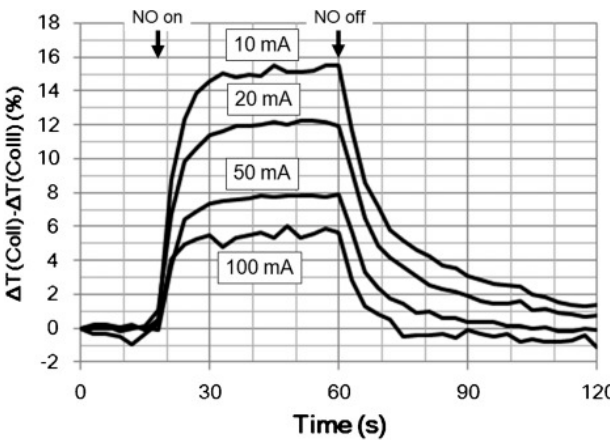
Figure 19. Transient sensor response changes during exposure (1 ppm NO) and recovery (N 2 ) for the Co-TPP/cellulose sensor measured at different LED driving currents. Reprinted with permission from [90]. Copyright 2016 Elsevier.